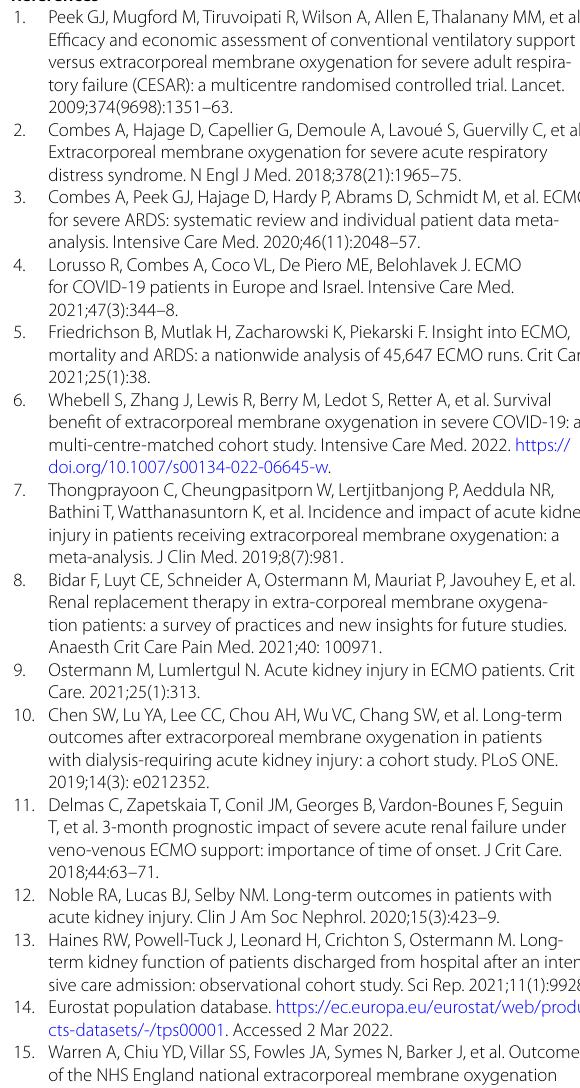
230) relative to ECMO =